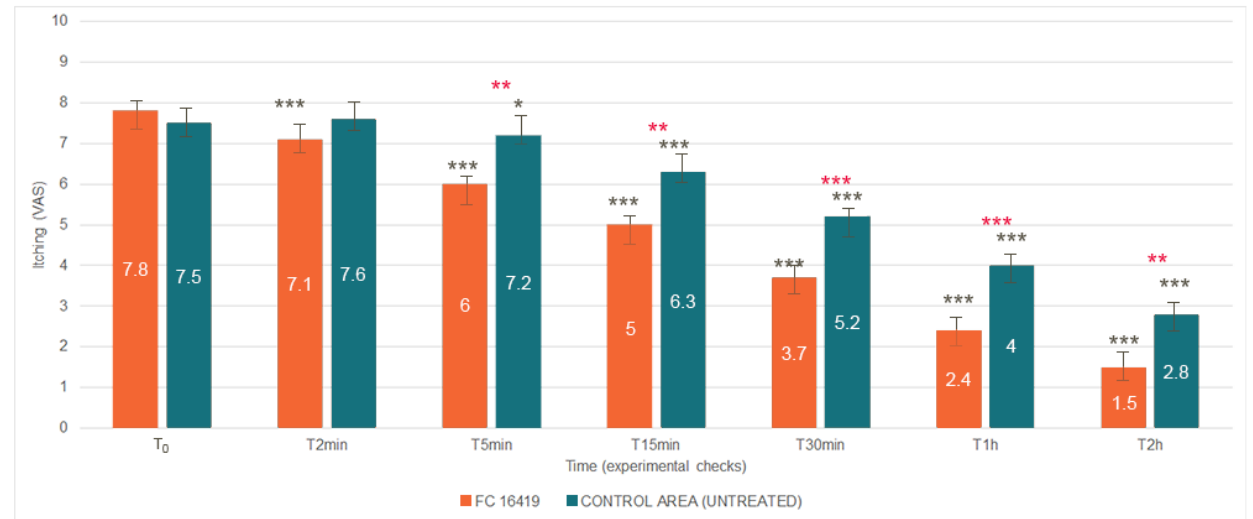
Figure 6. Evaluation of itching (VAS score) caused by bites after application of FC 16419 and on untreated bites (Data are reported as mean ± SEM). Black asterisks in the graph report the intra-group statistical analysis (vs. T 0 ) and red asterisks the inter-group statistical analysis (vs. untreated). Legend (significance): *** p < 0.001; ** p < 0.01; * p < 0.05. The participants evaluated the degree of skin irritation after mosquito bites, too